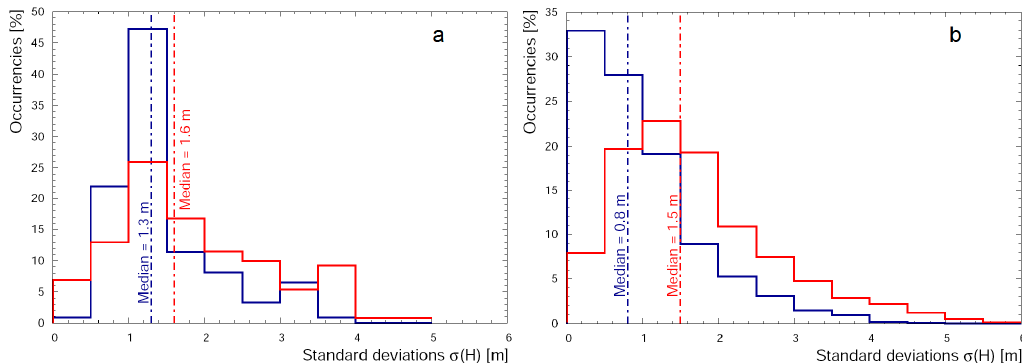
Figure 13. Distribution of σ (H) (standard deviations of heights) calculated for GPSABC built-in solution (red solid line) and with double-difference post-processing (blue solid line), in the altitude ranges